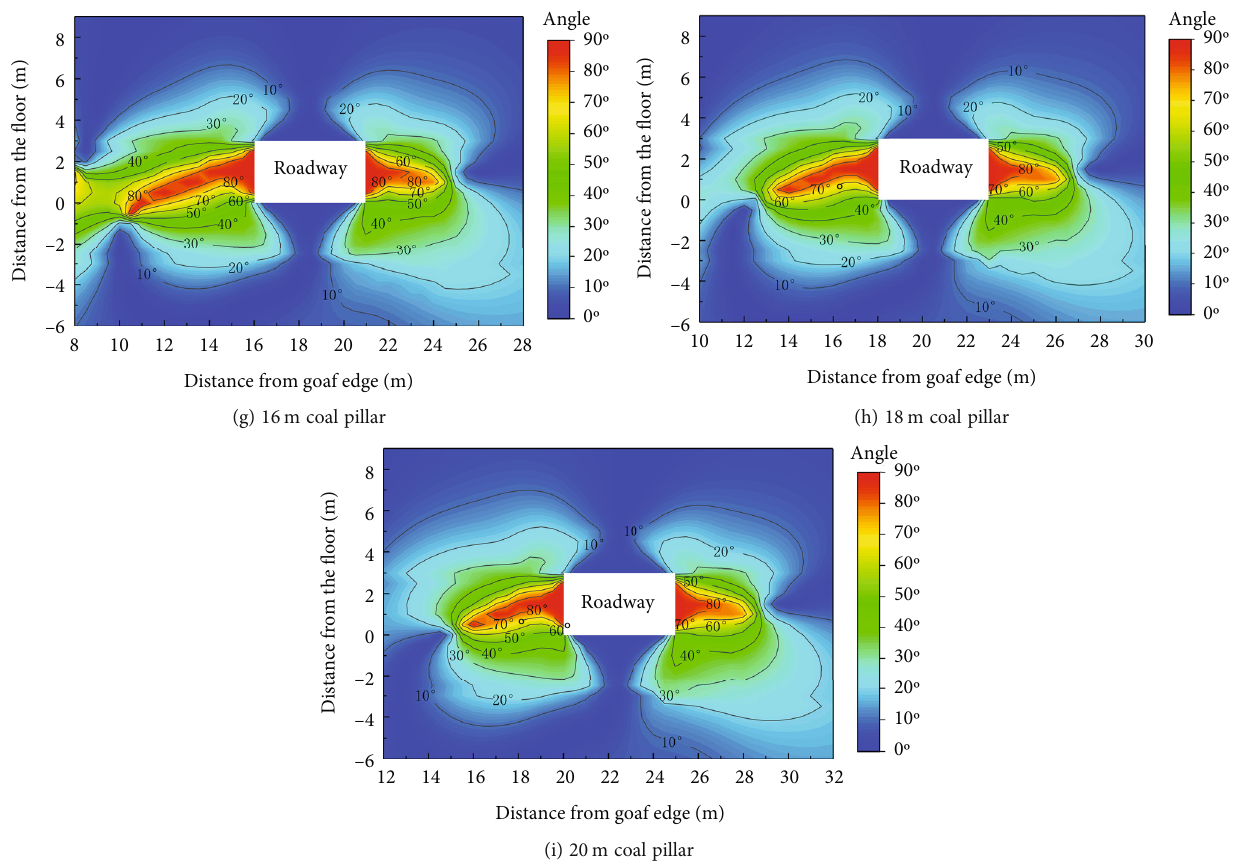
Figure 4: Angle cloud chart of maximum principal stress and horizontal direction of surrounding rock. (left side is coal pillar, right side is coal